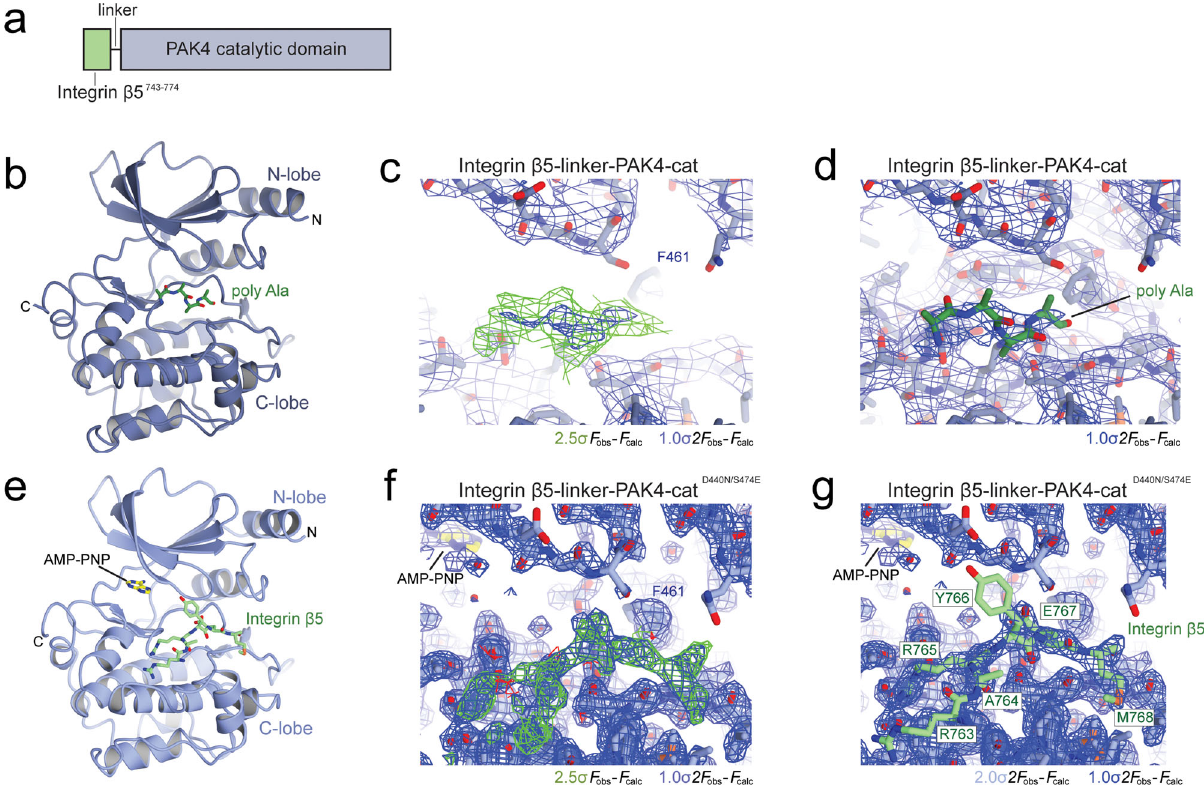
Fig. 2 Structure determination of integrin β 5 chimera with PAK4. a Schematic of chimeric integrin β 5-PAK4. The Linker region is a 12-residue -Ser-Ser- Gly- repeat. b – d P 6 3 structure of integrin β 5-PAK4 chimera at 3.5 Å (not submitted to PDB). e – g P 4 1 2 1 2 structure of integrin β 5-PAK4 D440N/S474E chimera (PDB ID: 7S47). Panels c and f show electron density maps that are unbiased by integrin β 5, i.e. prior to adding integrin β 5 to the model. Panels d and g show the fi nal re fi ned maps. F obs – F calc maps contoured at + 2.5 σ (green) and − 2.5 σ (red). 2 F obs – F calc maps contoured at + 1 σ (blue) and + 2 σ (light